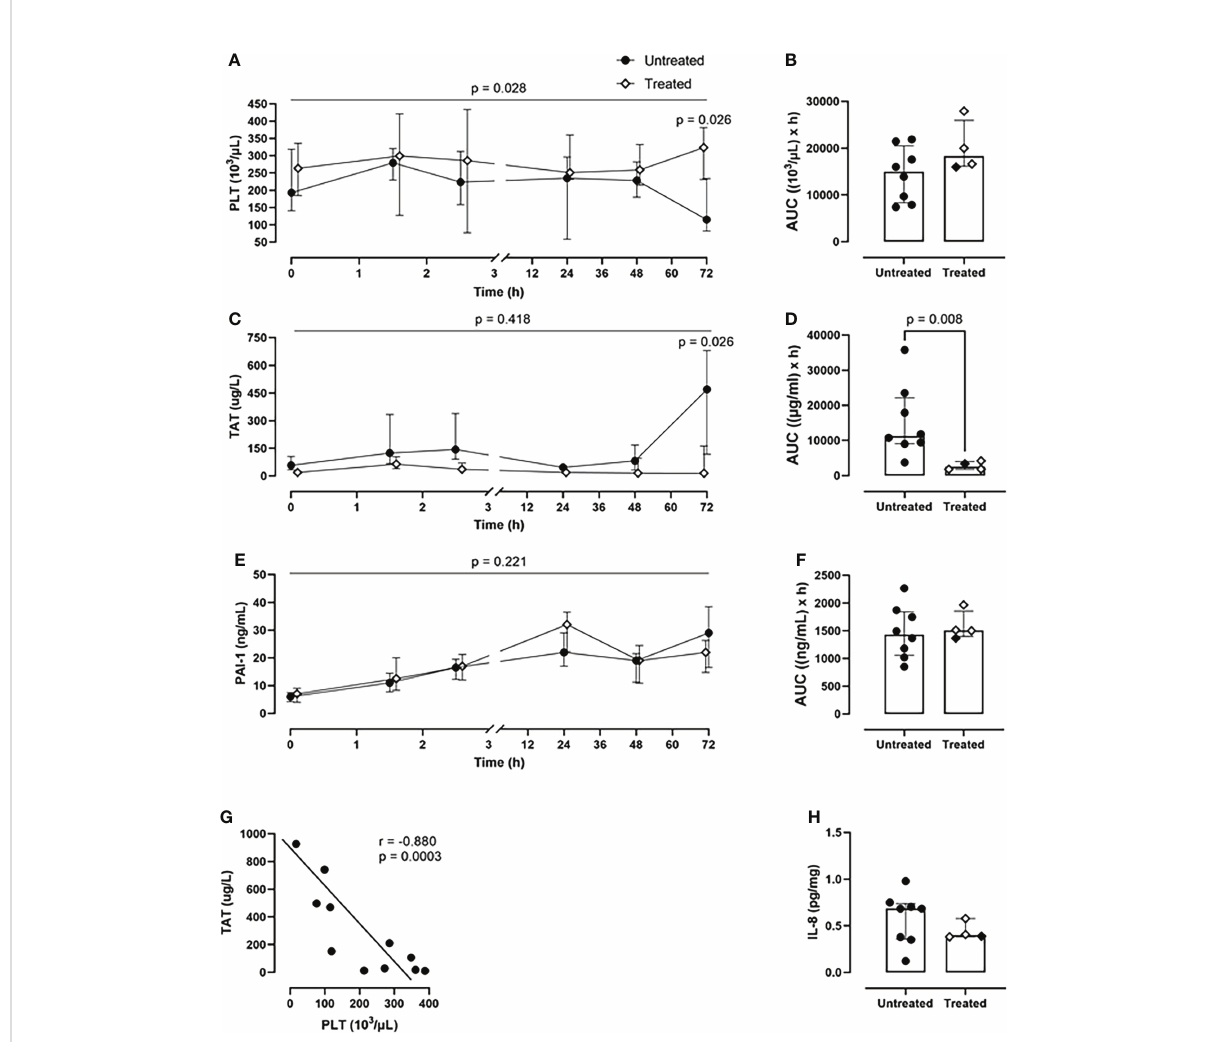
FIGURE 5 Coagulation parameters. (A) PLT count monitoring and (B) PLT count AUC analysis revealed a reduced PLTs consumption in the treated group (n=4), compared to the untreated group (n=8). (C) TAT monitoring and (D) TAT AUC analysis showed a signi fi cant reduction in TAT complexes formation in the treated group (n=4), but not in the untreated group (n=8). (E) PAI-1 monitoring and (F) PAI-1 AUC did not differ between the two groups. (G) Spearman correlation analysis shows a negative statistically signi fi cant correlation between TAT values and PLTs count in blood 72-h post-injury. (H) IL-8 measurement in BALF showed a reduction of the IL-8 levels in the treated group (n=4) compared to the untreated group (n=8). Overall p-value for group comparison of treated vs. untreated animals over time is displayed above the summary trajectories. In the AUC graphical representation, the fi rst pig, receiving lower inhibitor dosage, is represented as black fi lled